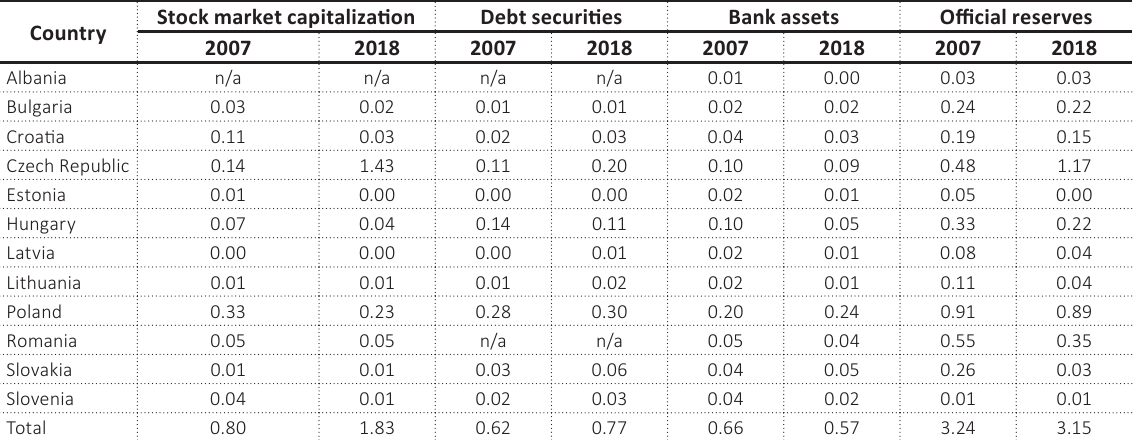
Table 1. CEE countries’ positions in the global financial system in 2007 and 2018,